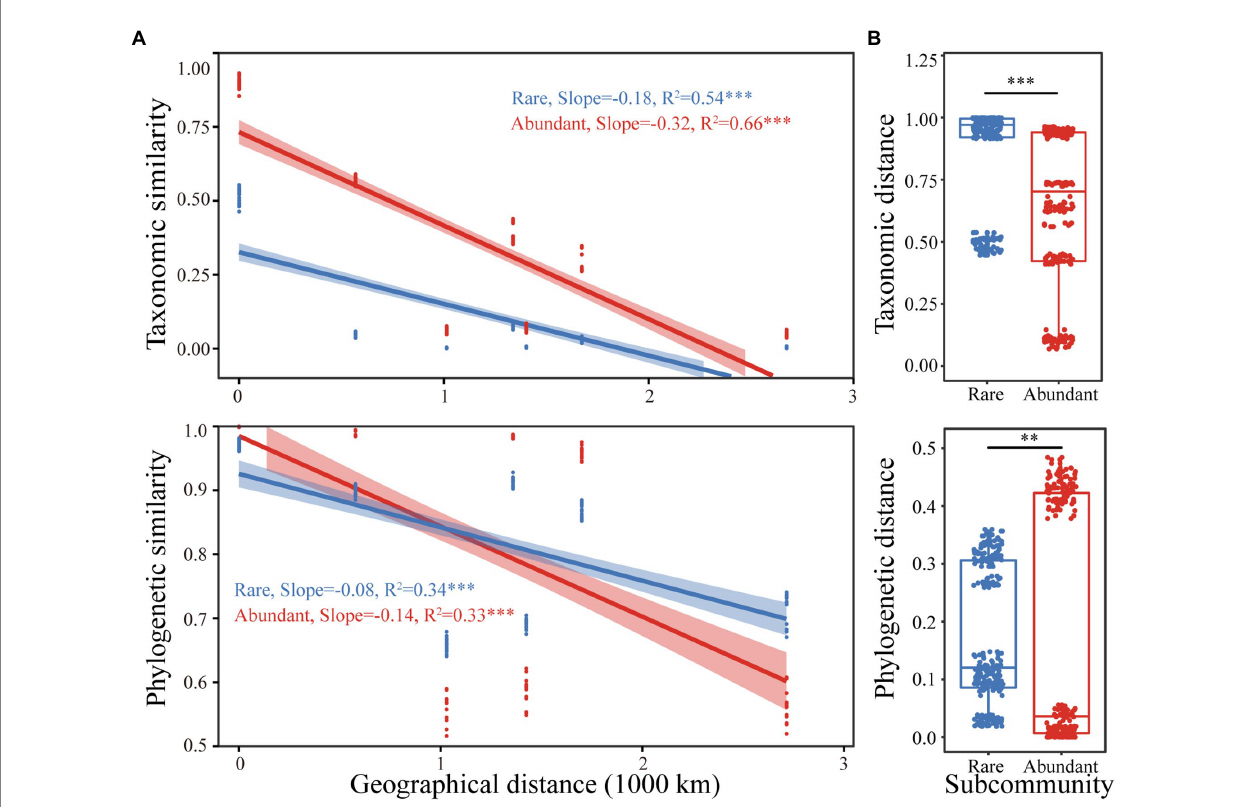
(Figure 5C). Variable selection (61.7%) had the largest contribution to the subcommunity assembly of rare bacteria, but variable selection (40%) and dispersal limitation (25.8%) contributed most to